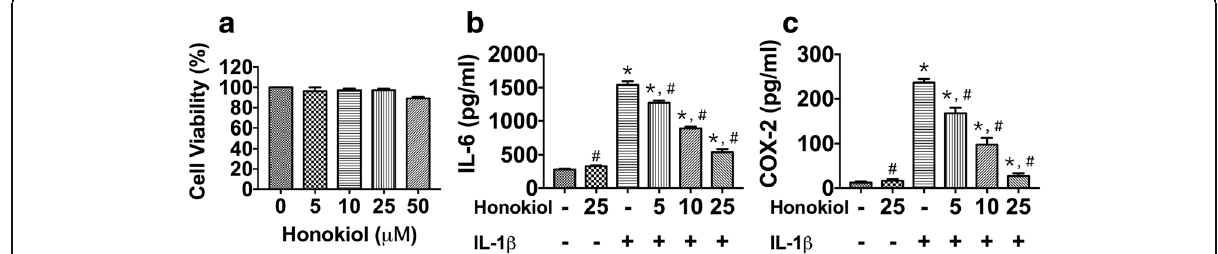
Fig. 3 Cell viability and the production of IL-6 and COX-2 in a gradient dose of honokiol. 2nd passage hUC-MSCs were cultured in high glucose α -MEM containing 10% FBS, 100 U/ml penicillin and 0.1 mg/ml streptomycin. A gradient dose of honokiol (0, 5, 10, 25, 50 μ M) with or without IL- 1 β (10 ng/ml) were added for incubation for 24 h. a : Cell viability determination. b , c : IL-6 and COX-2 production. All results were presented as mean ± SD ( n = 6); p * < 0.01 versus control; p # < 0.01 versus IL-1 β alone (10 ng/ml IL-1 β without